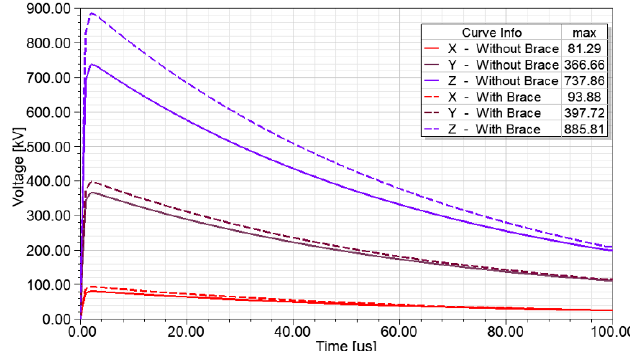
Figure 7. The potential measured at three different points (refer to Figure 4a) of the transmission line subjected to basic insulation level (BIL) voltage.